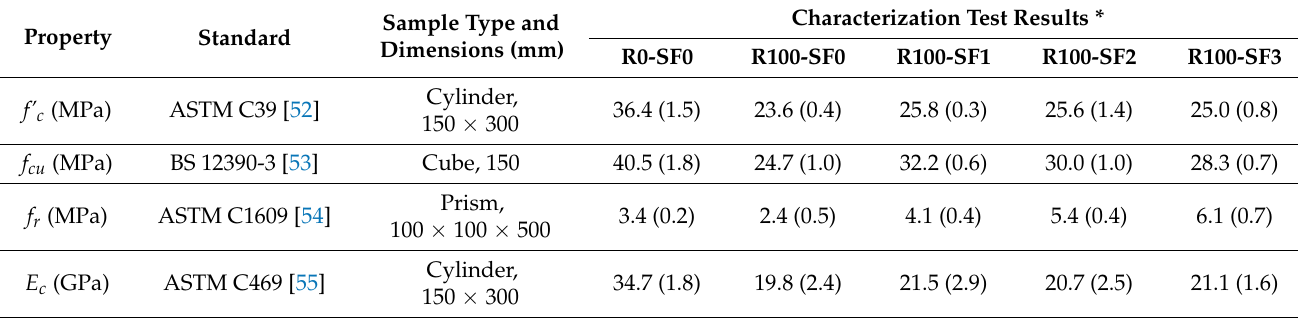
Table 1. Mechanical properties of concrete mixtures.